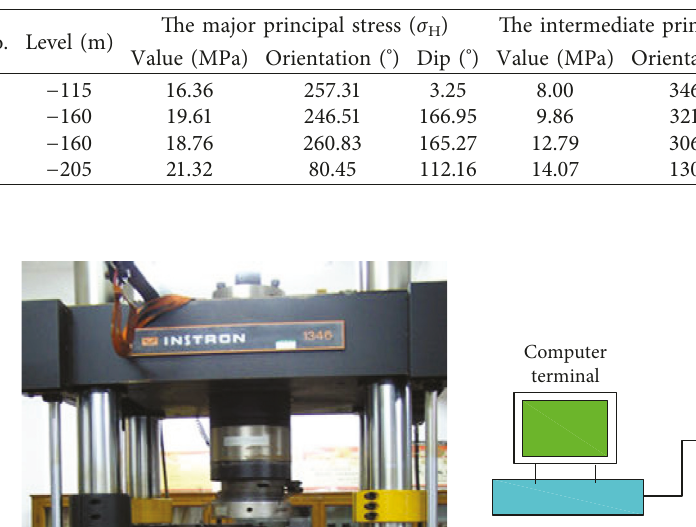
Figure 8: Hollow inclusion strain gauge. Table 1: Measurement results of principal stress at four points of Zhazixi Antimony Mine.